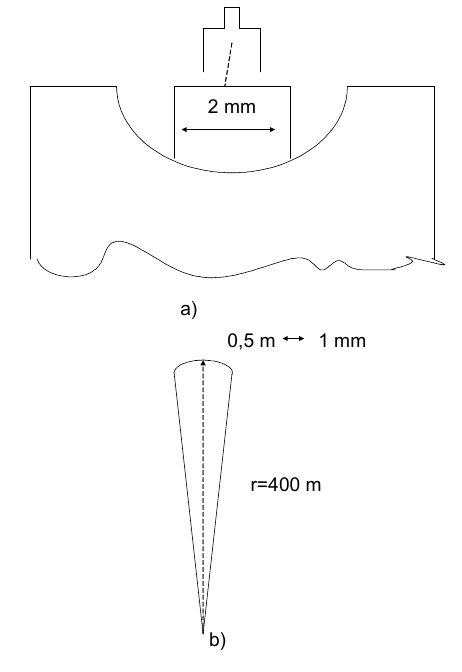
Fig 5. Diagram of aiming from a 400 m distance